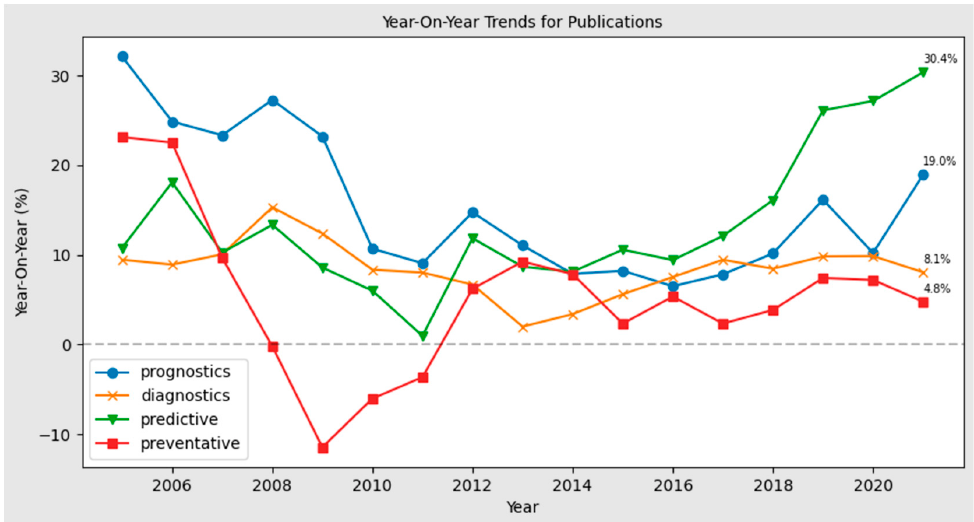
Figure 2. Year-on-year trend comparison of publications at a rolling average of five years for the period 2000–2021: “ Prognostics”; “ Diagnostics”; “ Predictive Maintenance”; “ Preventative OR Pre- ventive AND Maintenance” (source: Scopus).